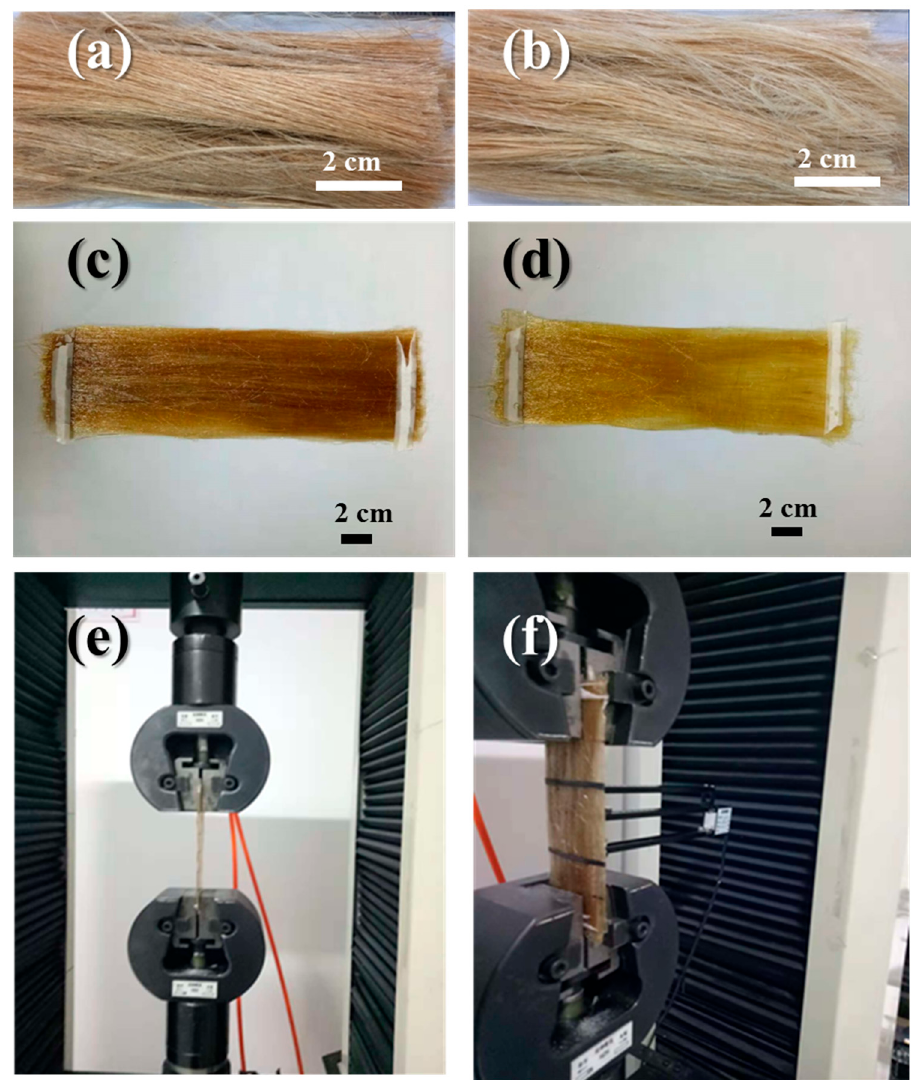
Figure 1. Images of ( a ) untreated (raw jute) and ( b ) chemically treated jute fibers; jute fiber–epoxy composites from unidirectional ( c ) untreated and ( d ) chemically treated fiber and ( e ) front view and ( f ) side view of sample grip arrangement on Instron 1195 tensile testing instrument (Instron, Norwood, MA, USA).